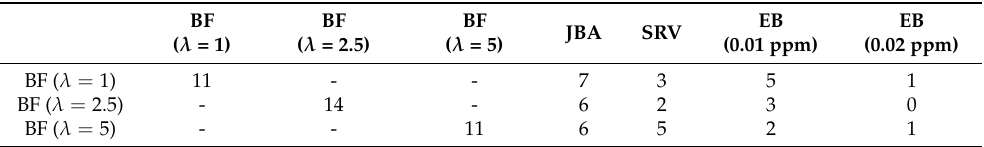
Table 3. The three different BF approaches (with λ = 1, λ = 2.5, and λ = 5) individually compared to JBA, SRV, and the equidistant binning method. The numbers indicate how often each method was selected as the “best